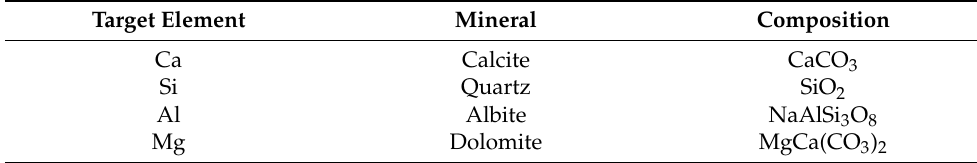
Table 2. Compounds used as the standards for the quantitative EDS microanalysis.